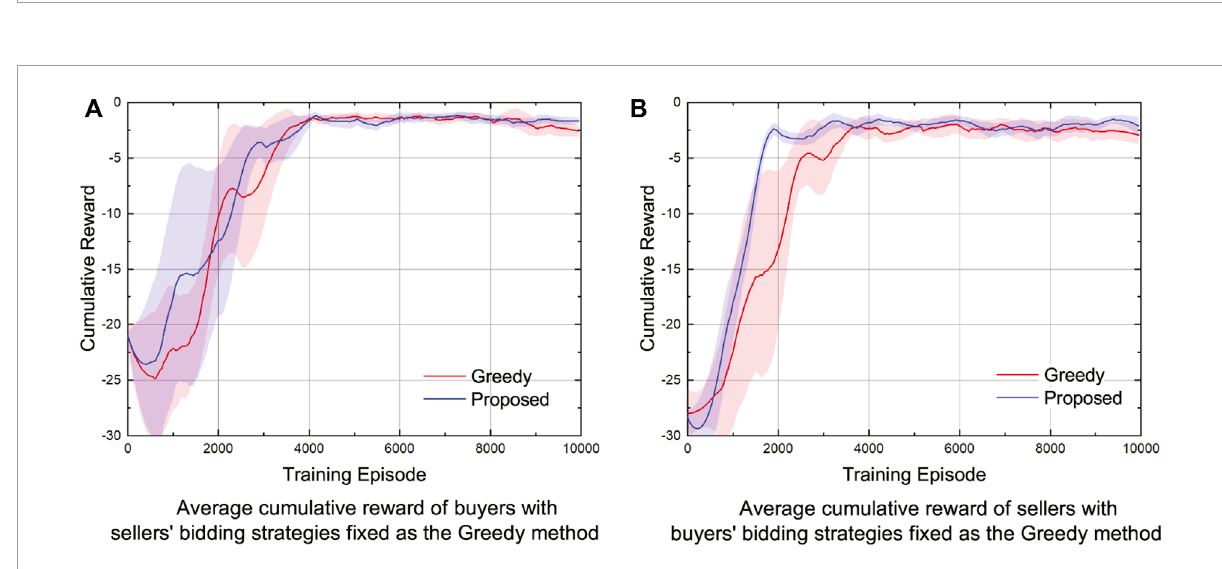
FIGURE 5 Average cumulative reward of (A) buyers and (B) sellers with the number of both buyers and sellers set as